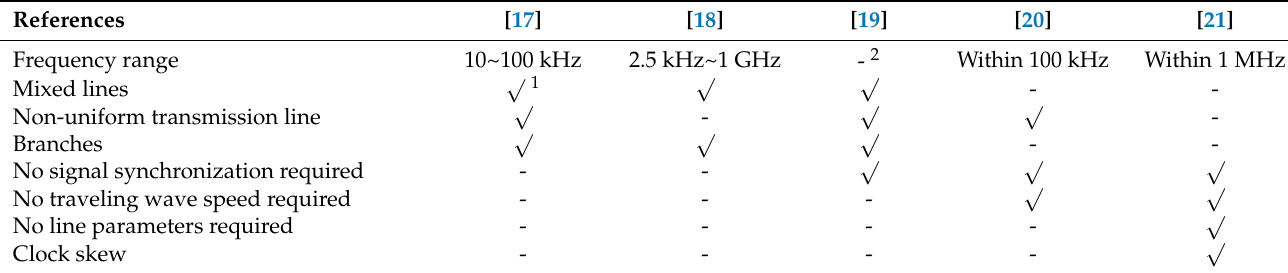
Table 2. The summary of the improvements of the traveling-wave-based